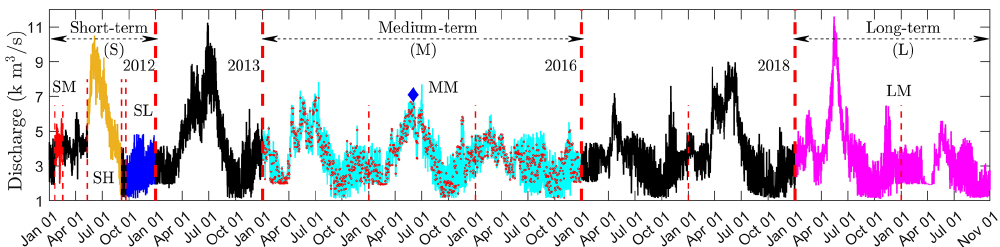
Figure 4. The time series of inlet flow rate during the years 2011–2019. S, M, and L denote short, medium, and long term. SM, SH, and SL denote the medium, high, and low flow in the short-term period; MM and LM denote mixed flow in the medium-term and long-term